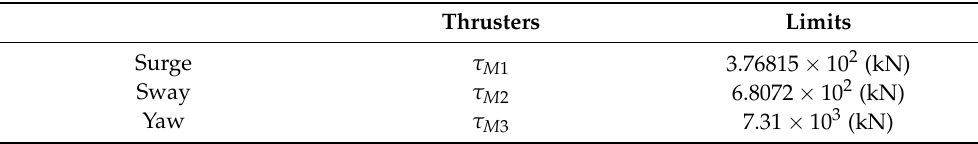
Table 2. Thruster input saturation limit values.